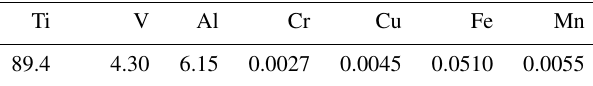
Table 1. Chemical composition of Ti-6Al-4V (wt%). Ti V Al